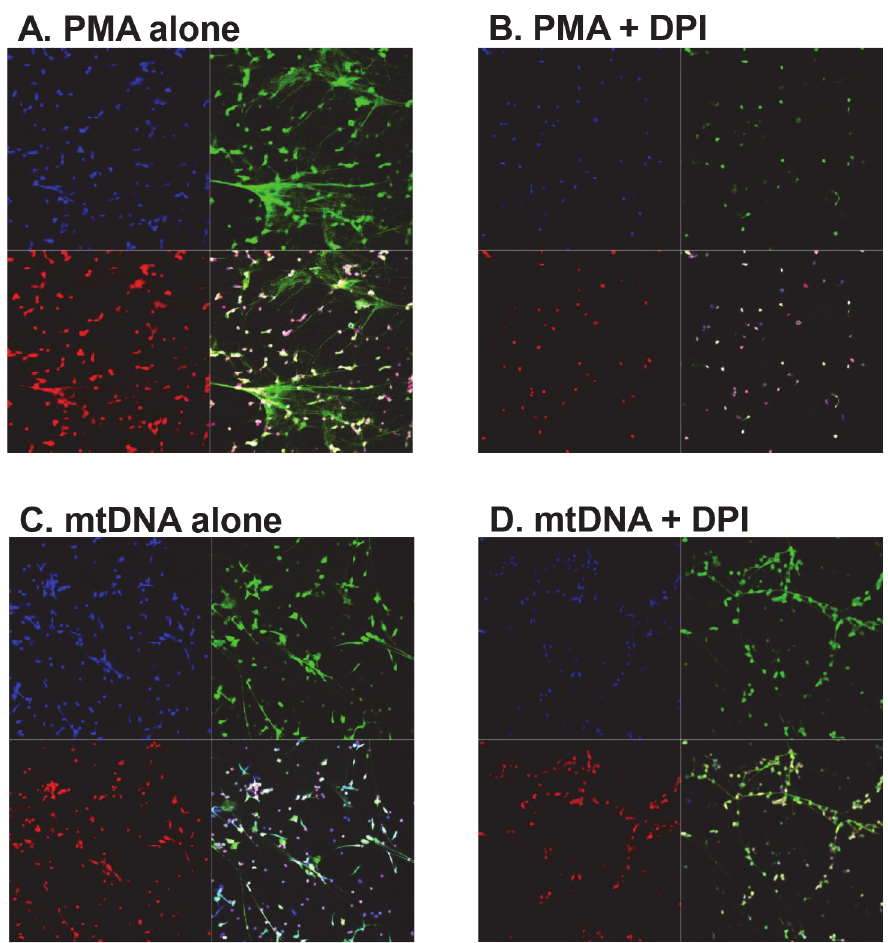
Fig 2. MtDNA-induced NET formation is independent of NADPH oxidase. PMN were pre-treated with 10 μ M DPI for 1 h before the stimulation (B and D). Then either 20 nM PMA (A and B) or 50 μ g/mL mtDNA (C and D) was applied for 3 – 4 h. NETs were detected as described in Materials and Methods. Experiments were repeated more than three times. Magnification